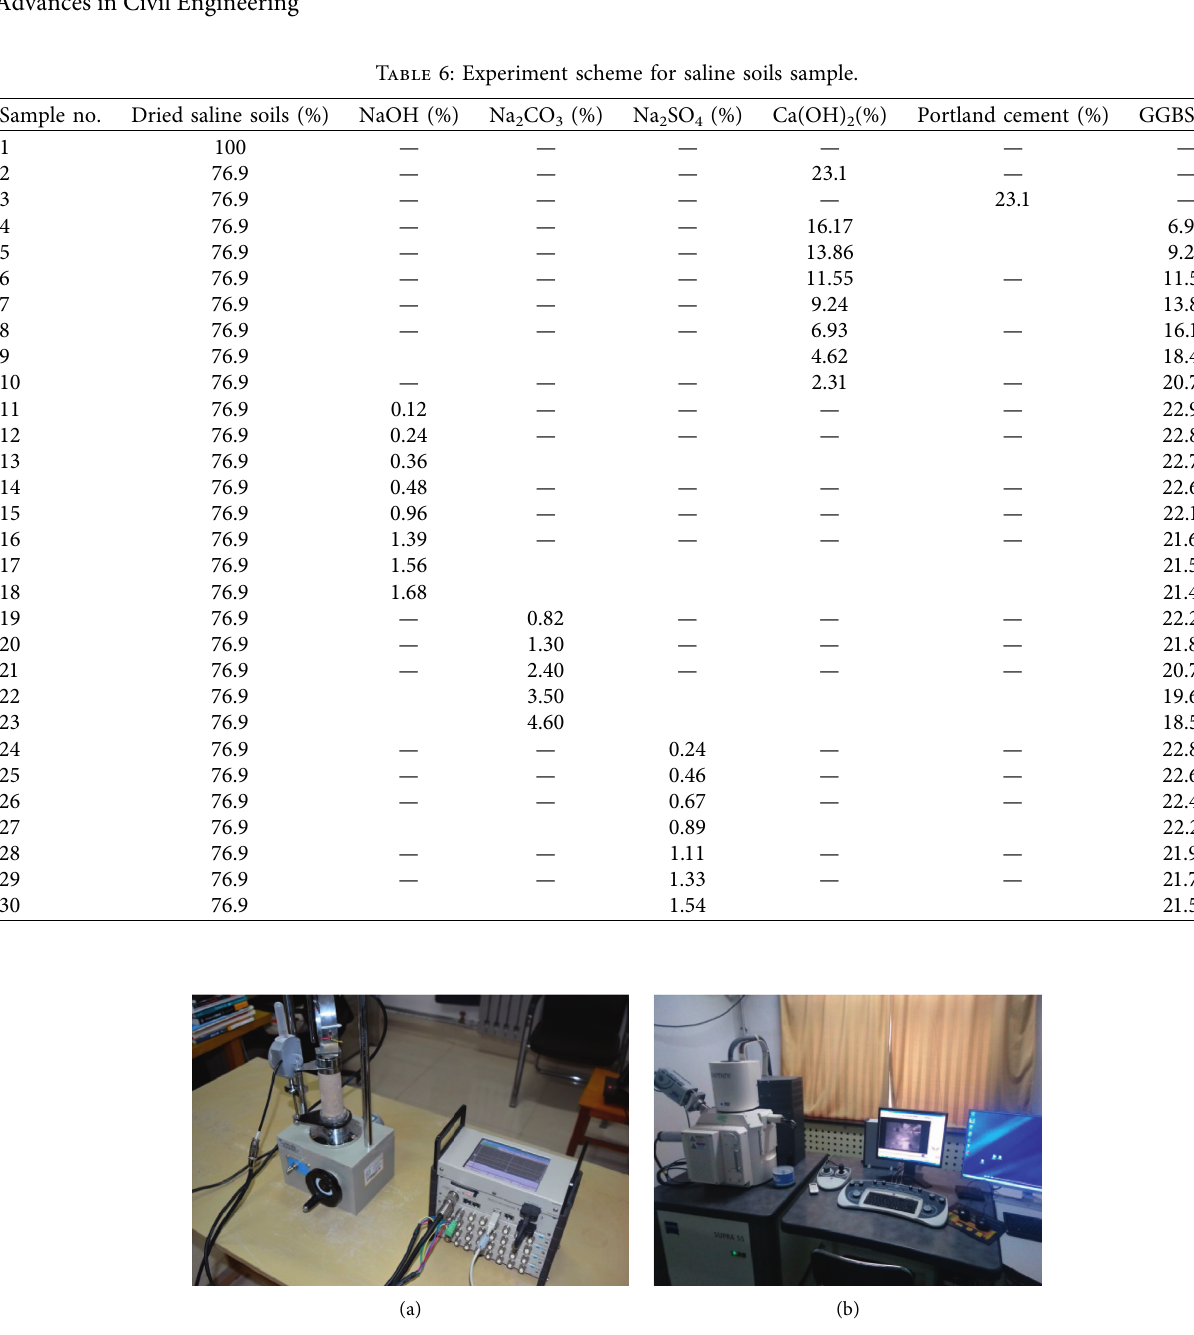
Figure 3: Apparatus used in test. (a) Unconfined compressive apparatus and (b) scanning electron